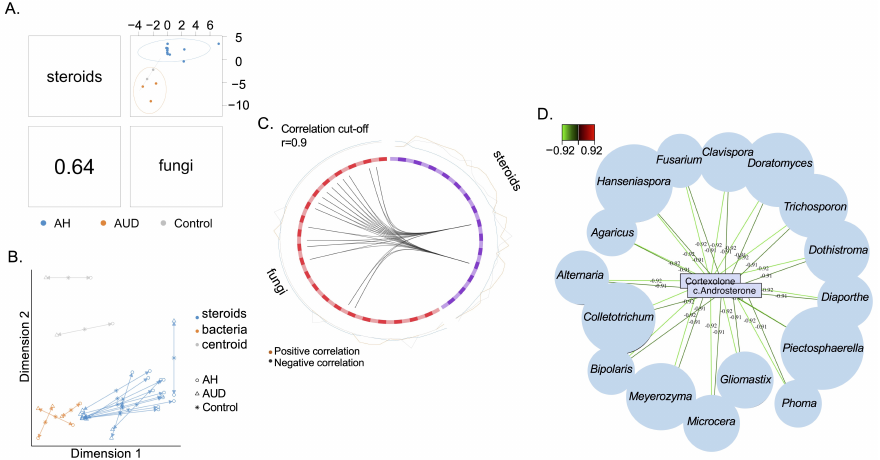
Figure 4. Correlated serum steroids and gut fungi. ( A ) The overall correlation between serum steroids and gut fungi is 0.64. ( B ) Integrative analysis between serum steroids and gut fungi. Each sample corresponds to one arrow, with short arrows indicating strong agreement between two data sets and long arrows indicating a disagreement. ( C ) Correlations between serum steroids and gut fungi with a cut-off set to 0.9. Black line: negative correlation. ( D ) Correlations between serum steroids and gut fungi. Ctrl, control subjects, AUD, patients with alcohol use disorder; AH, alcohol-associated